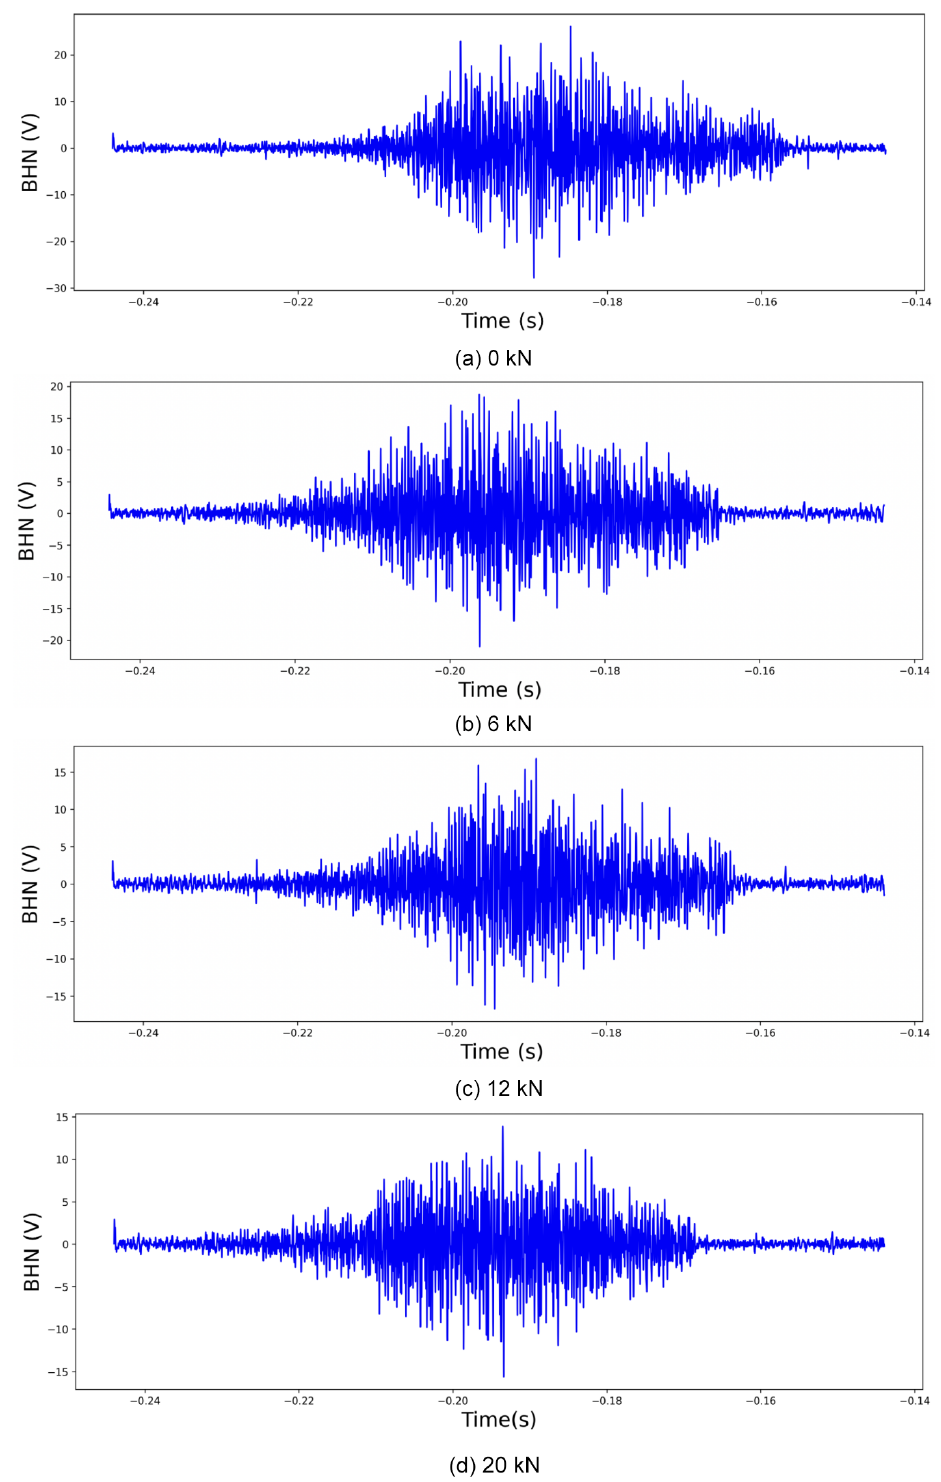
Figure 2. The Barkhausen noise (BHN) of steel samples under different loads: (a) 0kN, (b) 6kN, (c) 12kN, and (d) 20kN.